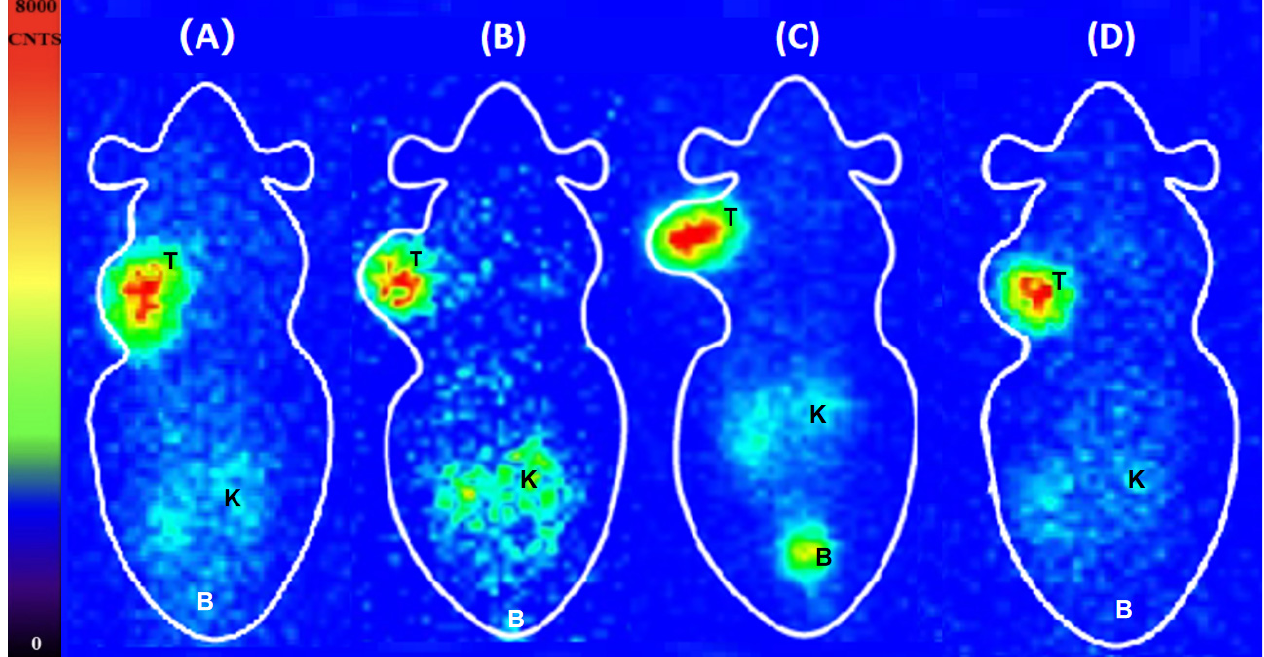
Figure 6. Small-animal SPECT images of [ 177 Lu]Lu-PSMA-BP ( A ), [ 177 Lu]Lu-PSMA-4PY ( B ), [ 177 Lu]Lu-PSMA-Q ( C ) and [ 177 Lu]Lu-PSMA-617 ( D ) in mice bearing 22Rv1 at 24 h p.i. (T: tumor, K: kidney, B: bladder).